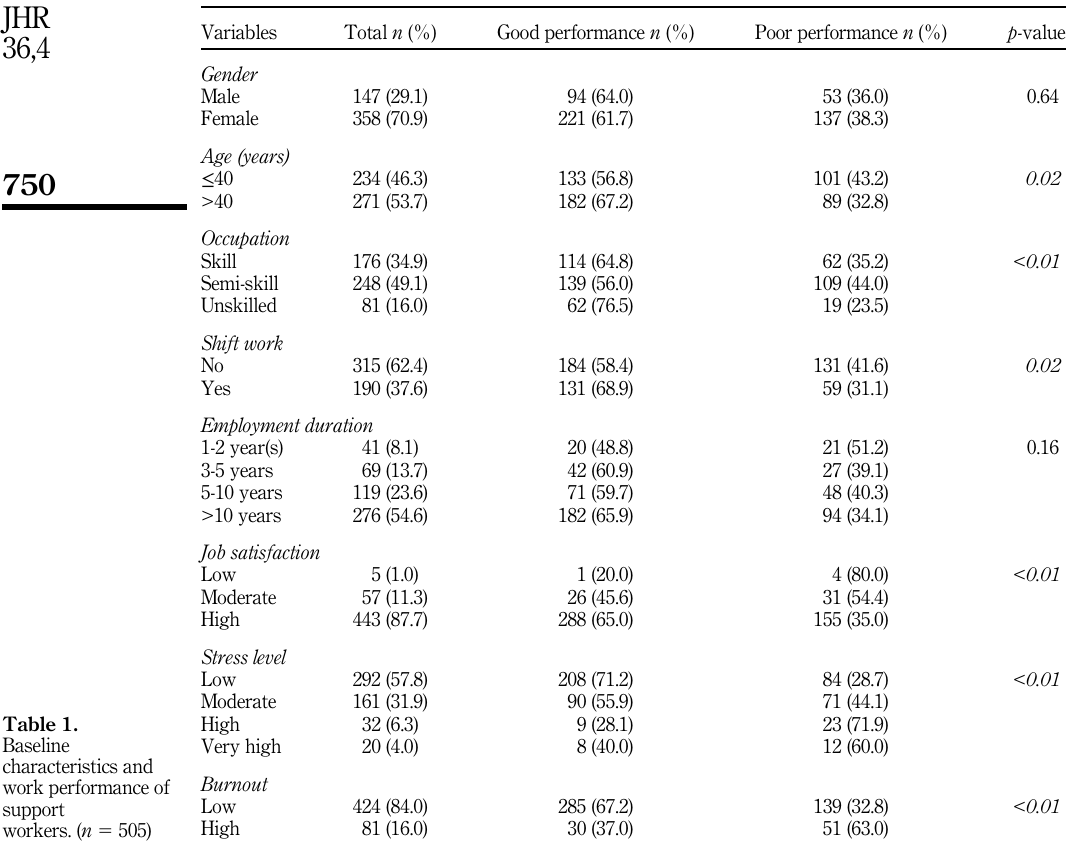
Table 1. Baseline characteristics and work performance of support workers. ( n 5